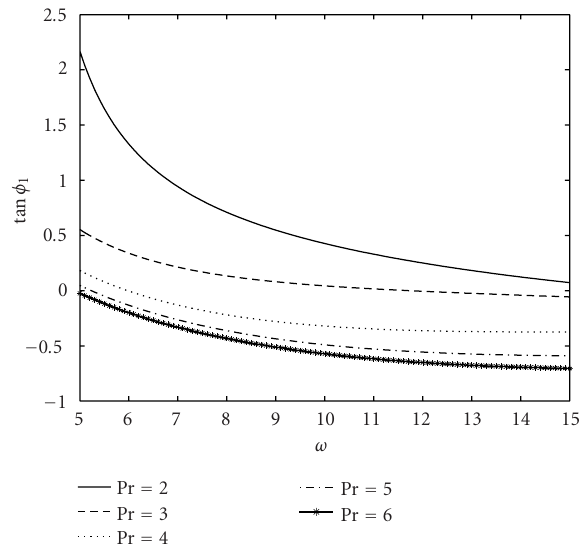
Figure 4.6. Tangent of phase shift of shear stress due to main flow for Gr = 5 . 0, S = 1 . 0, z = 0 . 0.